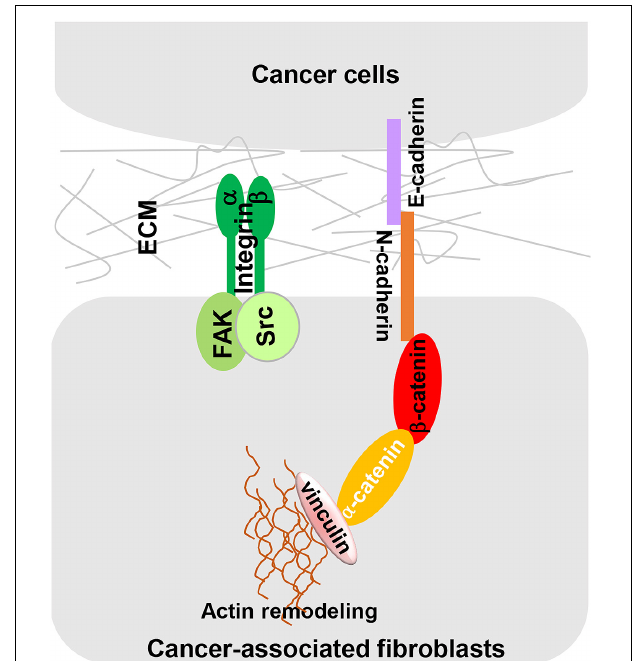
FIGURE 3 | A heterotypic E-cadherin/N-cadherin complex mediates CAF-SCC cell contact. As reported by Labernadie et al. (2017) intercellular physical force is transmitted between SCCs and CAFs by a heterophilic adhesion complex involving N-cadherin at the CAF membrane and E-cadherin at the cancer cell membrane. This heterotypic CAF-cancer cell interaction triggers β -catenin recruitment, α -catenin/vinculin interaction, and actin remodeling, allowing CAFs to exert an intercellular physical force on cancer cells and promote cooperative tumor invasion.